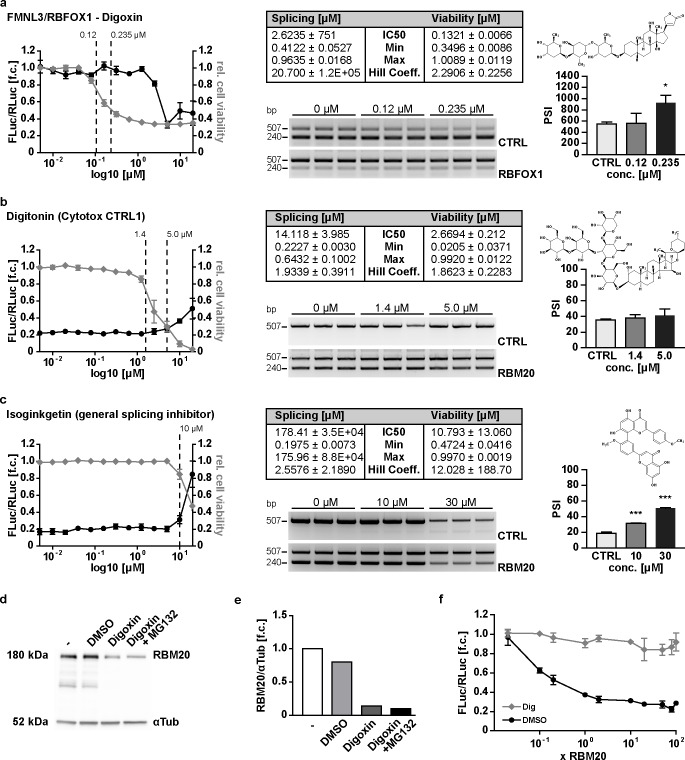
Specificity of the inhibitory effect of cardenolides on RBM20-mediated titin splicing.Figure layout and panels as described in Figs 3 and 4. (a) An independent minigene containing FMNL3 exons 25-26 was co-transfected with RBFOX1 and does not respond to digoxin until cell viability is below 30% (N = 3). (b) Digitonin does not affect the splice reporter readout until cell viability is below 20%. There is no effect on the mRNA level (N = 3). (c) Isoginkgetin treatment reduces alternative splicing and mRNA maturation (reduced PCR product at 507 bp in the control at 30 μM). (d, e) Digoxin treatment of co-transfected HEK293 cells leads to decreased expression of RBM20, which is not affected by addition of the proteasome inhibitor MG132. (f) Digoxin dependent splicing inhibition does not depend on the reporter to RBM20 ratio. High concentrations of RBM20 co-transfected with the reporter do not compensate the inhibitory effect. 2-WAY-ANOVA: interaction, column and row factor <0.0001, (N = 4). *P<0.05, ***P<0.001 versus CTRL (Dunnett’s post-test). Data are presented as mean ±SD.